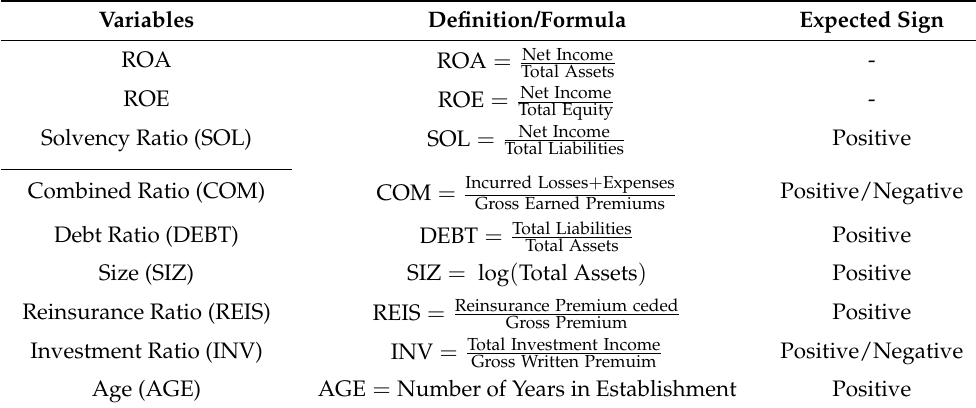
Table 2. Summary of Variables Under